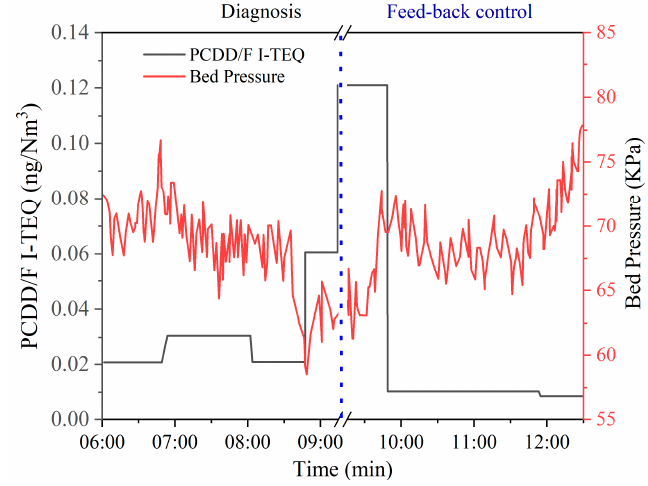
Figure 13. Diagnosis and feedback control of PCDD/F based on bed pressure.